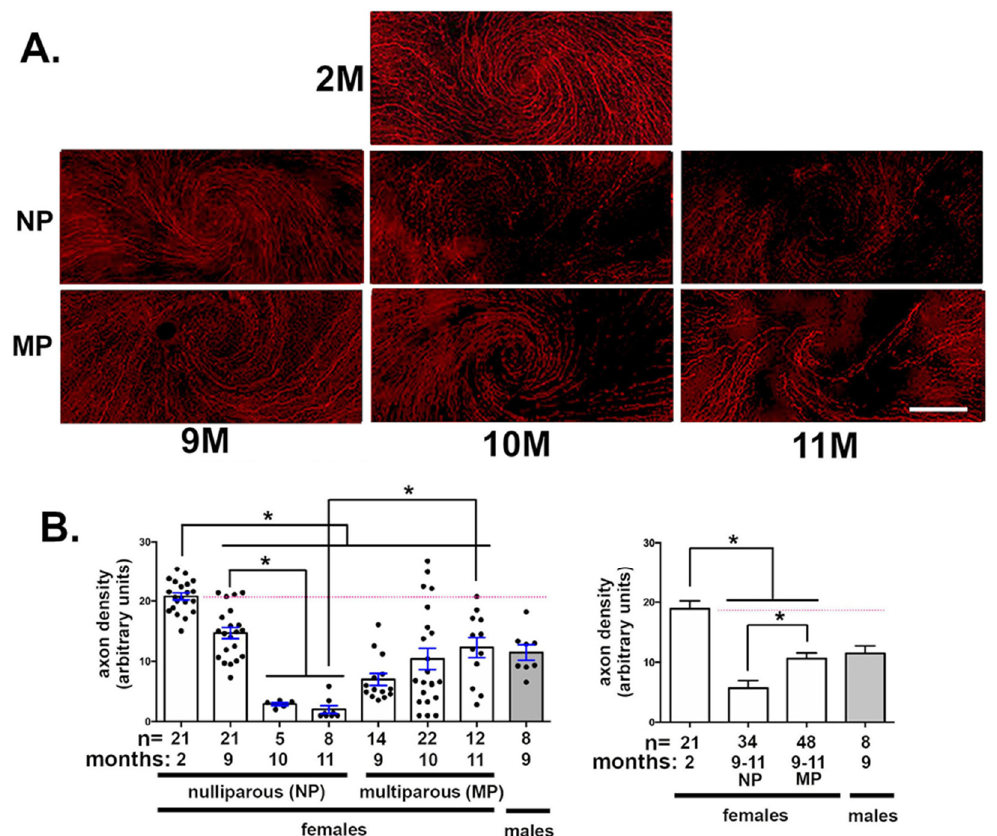
Figure 1. Axon density is higher in multiparous female mice compared to nulliparous female mice after 9 months (M) of age. Sholl analysis was performed on 2M nulliparous (NP) as well as 9, 10, and 11M NP and multiparous (MP) female mice and 9M male mice. ( A ) Representative Sholl images for female mice are shown. ( B ) Quantitation of axon density for each group is shown in B on the left. The numbers of mice are indicated. On the right, axon density data for clustered 9–11M NP and MP female mice are presented. Asterisks indicate significant differences with p values <0.05. The dotted pink line highlights axon density for 2M NP controls. Bar in A = 175 μ m.